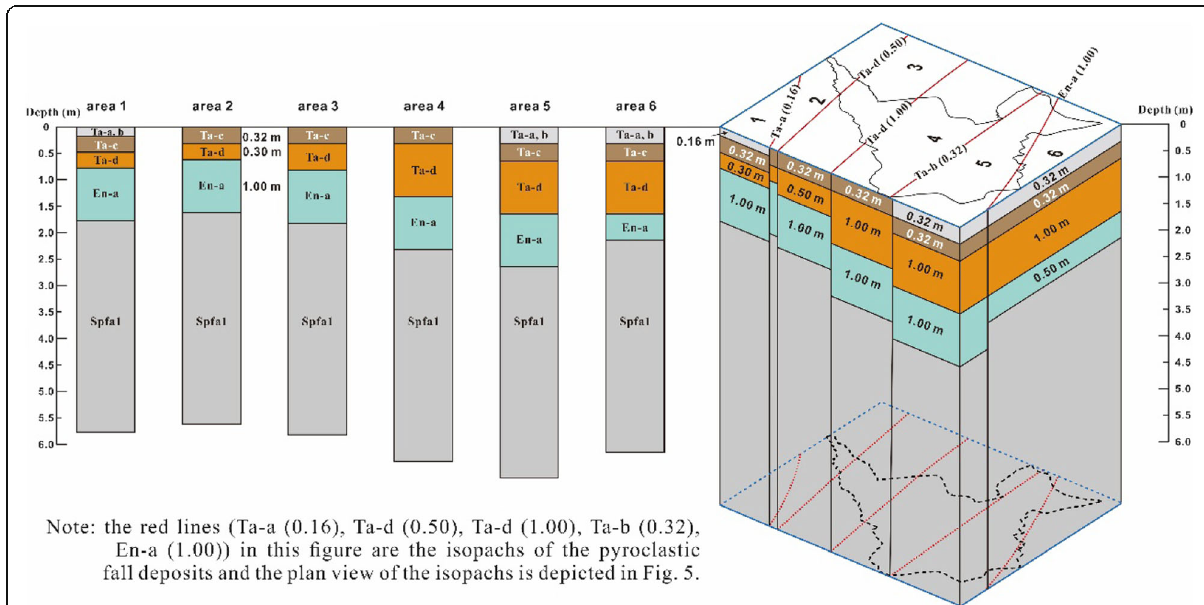
Fig. 6 Soil layers and corresponding depths of the six sub-areas classified based on the isopachs of pyroclastic fall deposits